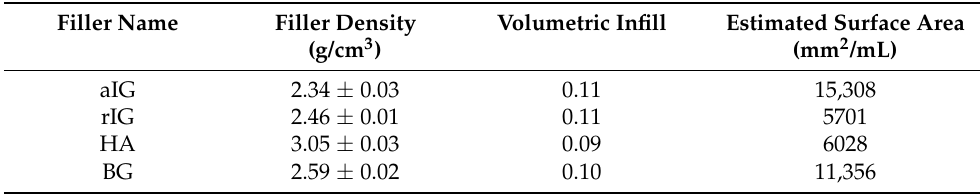
Table 2. Filler densities with standard deviation and calculated volumetric infill.